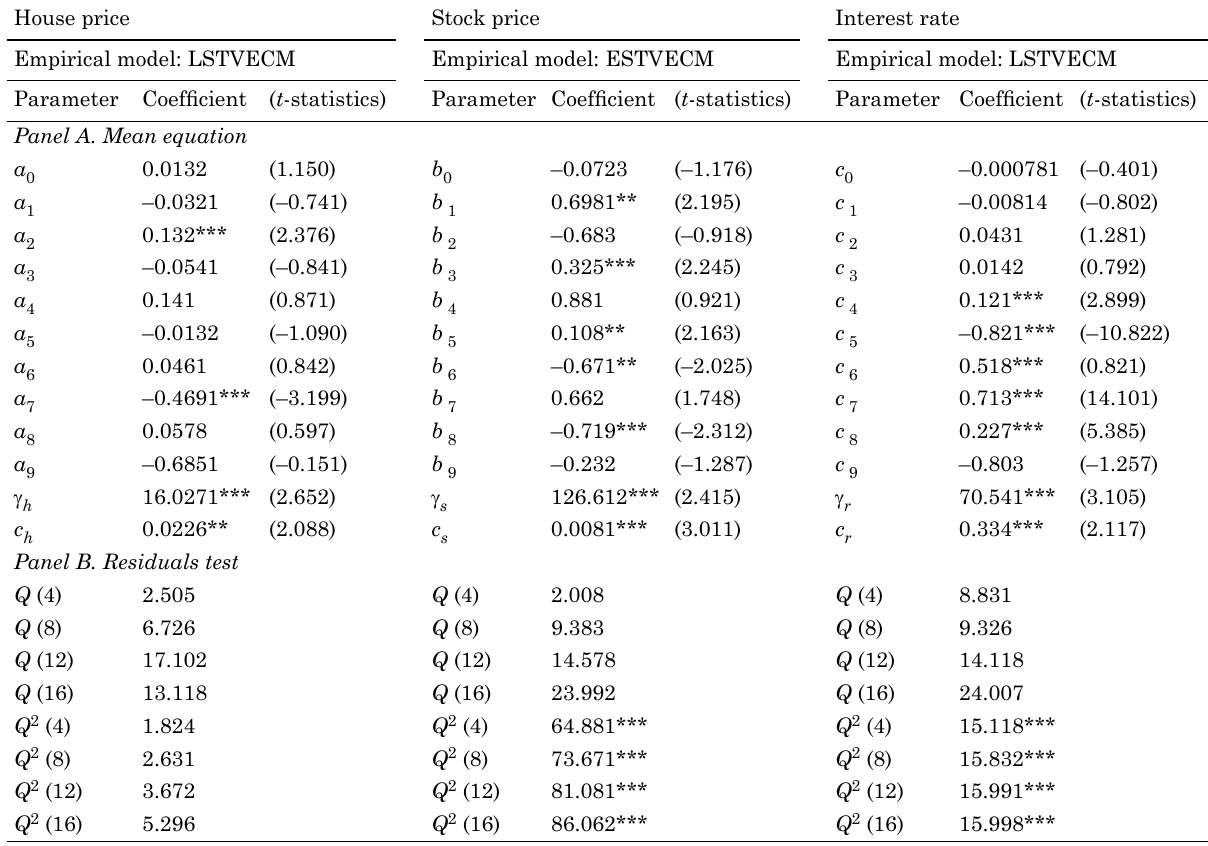
Table 8. Estimated result of STVECM: house price, stock price, and interest rate House